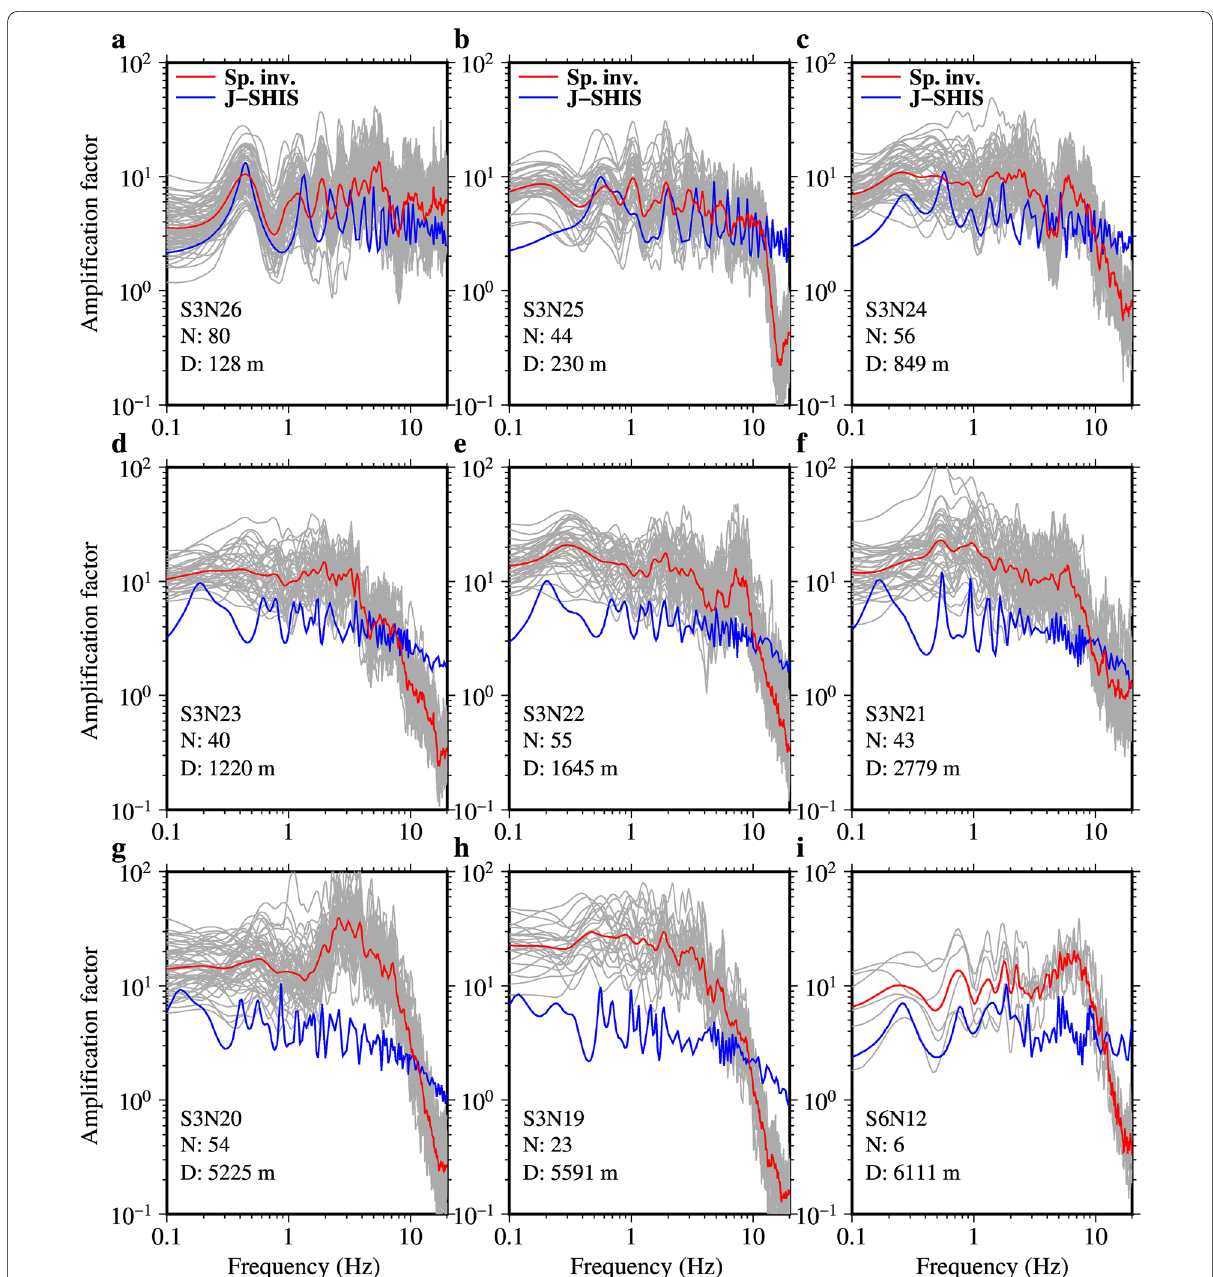
Fig. 9 Comparison of the site amplification factors (red lines) obtained from the spectral inversion with the theoretical amplification factors (blue lines) using the J-SHIS subsurface velocity model. The grey lines denote the site factors corresponding to each earthquake deduced by dividing the original spectra by the source spectrum of corresponding earthquake and path factors. The plots a , b , c , d , e , f , g , h , and i correspond to sites, namely, S3N26, S3N25, S3N24, S3N23, S3N22, S3N21, S3N20, S3N19, and S6N12, indicated in each panel (see Fig. 1 for the location of the sites). The number of earthquake records (N) used in the spectral inversion and the depth to the seafloor (D) are indicated for each site. See Additional file 4 for the J-SHIS model at the sites mentioned